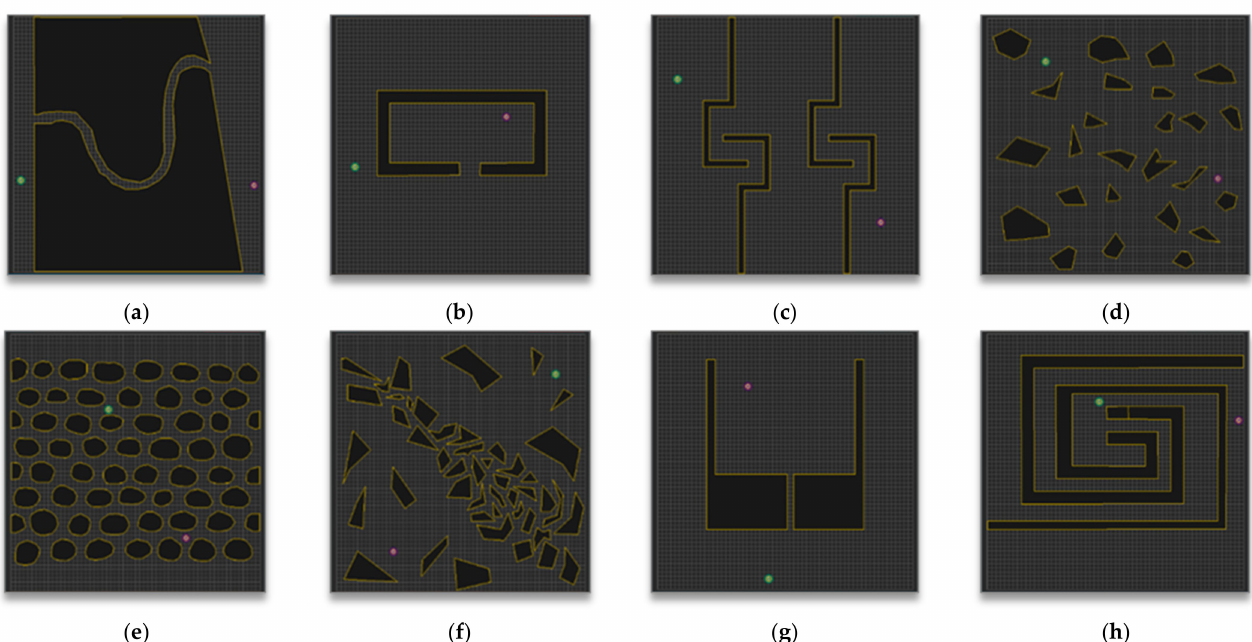
Figure 10. Maps for the experiment: ( a ) Map 1; ( b ) Map 2; ( c ) Map 3; ( d ) Map 4; ( e ) Map 5; ( f ) Map 6; ( g ) Map 7; ( h ) Map